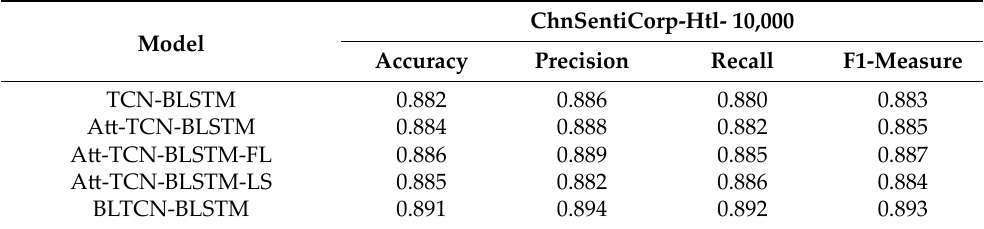
ChnSentiCorp‑Htl‑